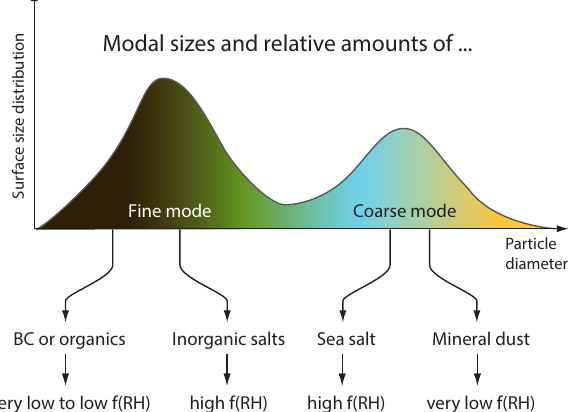
Fig. 7. Schematic overview of the factors influencing the scattering enhancement f (RH). The size and the relative contributions of the different modes with their distinct chemical composition (governing the hygroscopic growth and refractive index) all influence f (RH). This also includes the compensating effects of size and chemical